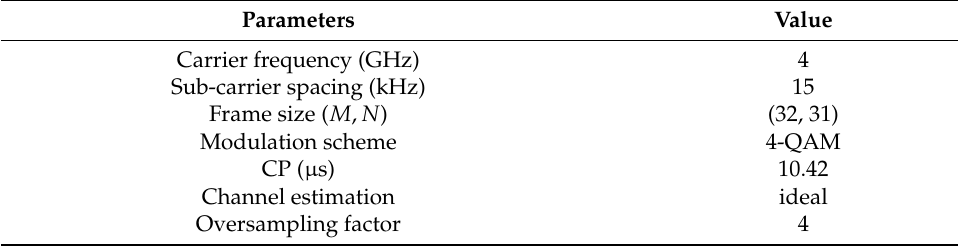
Table 3. Simulation